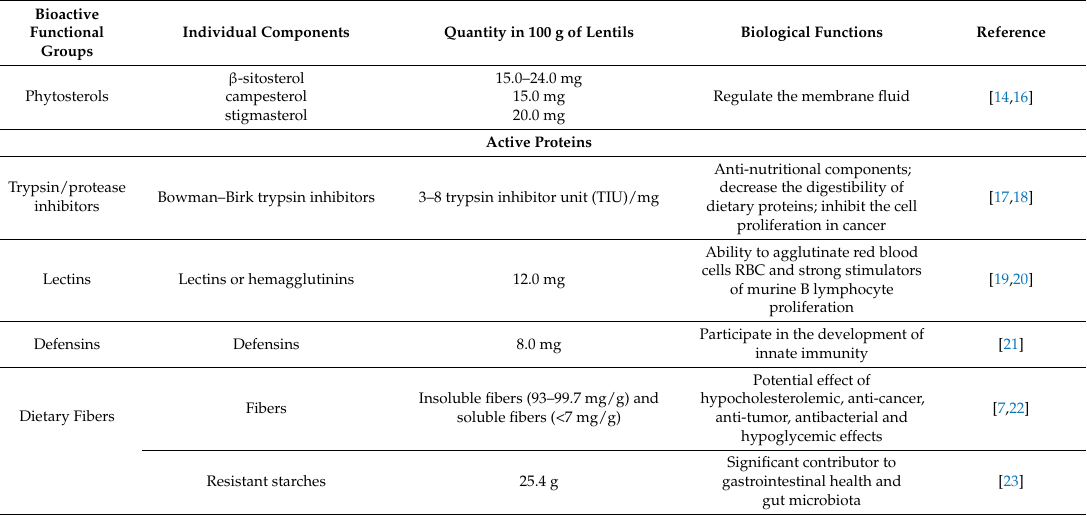
Table 2. List of bioactive functional groups in lentils and their biological